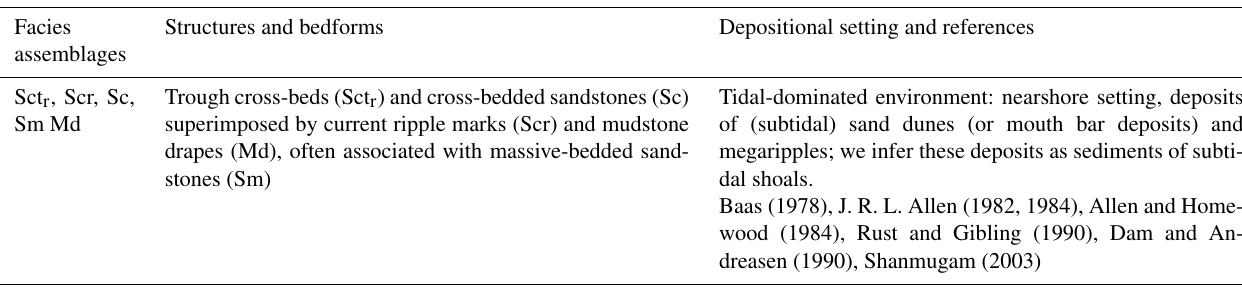
Table 4. Lithofacies encountered at the St. Magdalena site and Gurten drill core. Facies